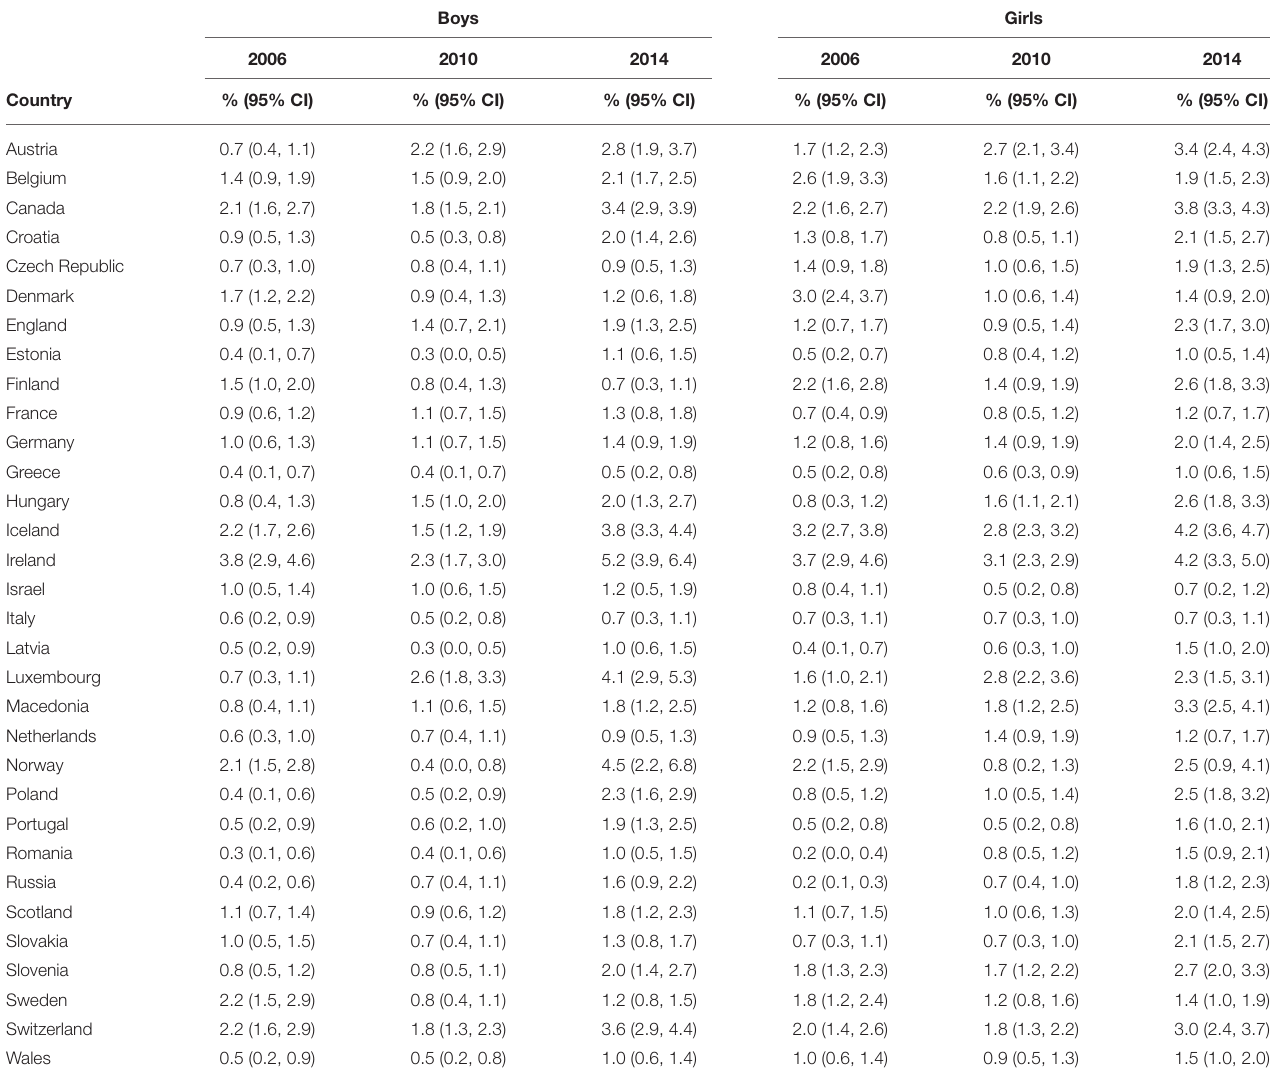
TABLE 3 | Prevalence of adolescents with a healthy lifestyle (reporting all five health behaviors) in 2006, 2010, and 2014 by sex and for each country of HBSC data.